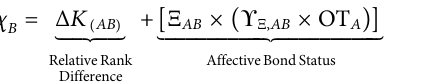
Cortisol (CT) “ Stress hormone ”